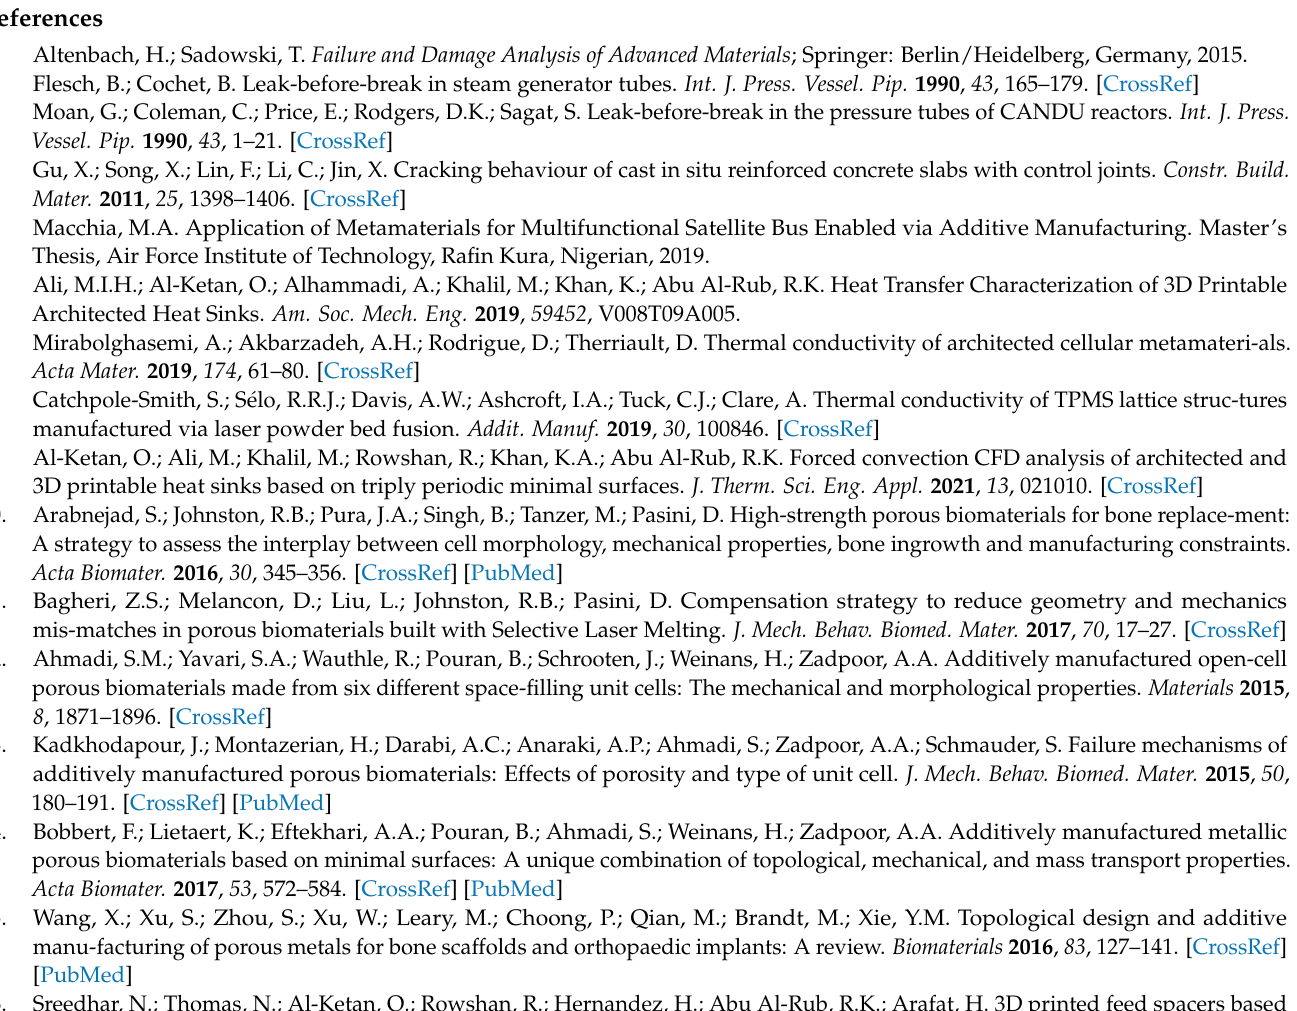
4- Coding the resulting surface φ new in MATLAB, or inputting the equation in the implicit function plotter of